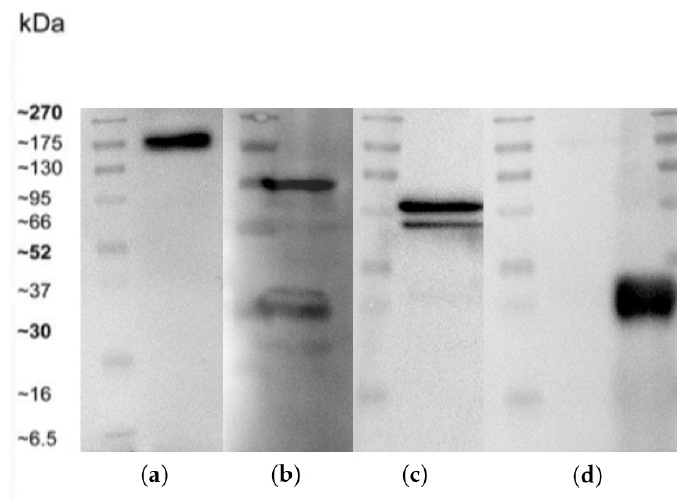
Figure 11. Expression of cell junctions’ proteins in bEnd.3 cells cultured on the porous membrane of Livebox2 after one week of flow conditions (100 µ L/min). Western blotting analysis: lane 1 ( a ), ZO-1 tight junctions’ expression; lane 2 ( b ), N-Cadherin adherens junctions’ expression; lane 3 ( c ) β -catenin adherens junctions’ expression. The blot was stripped and re-probed with an anti- β -actin polyclonal antibody to ensure equal loading of proteins in the remaining lanes ( d ). Molecular mass markers are indicated on the left of the Western blotting panels.